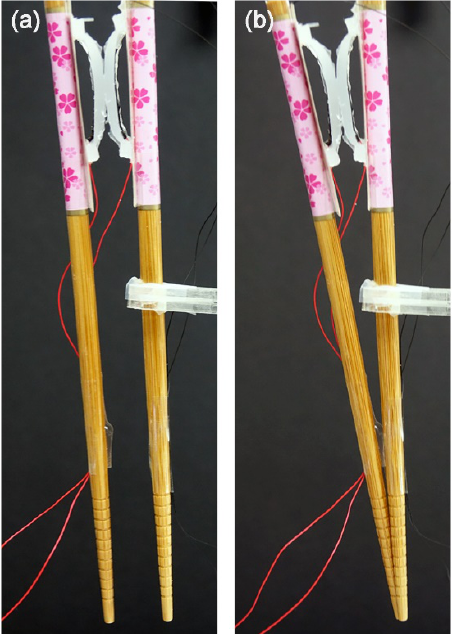
Figure 10. Motion of chopstick robot: ( a ) its original state without a voltage input, and ( b ) when the chopsticks are closed by the electrostatic force when voltage is supplied.